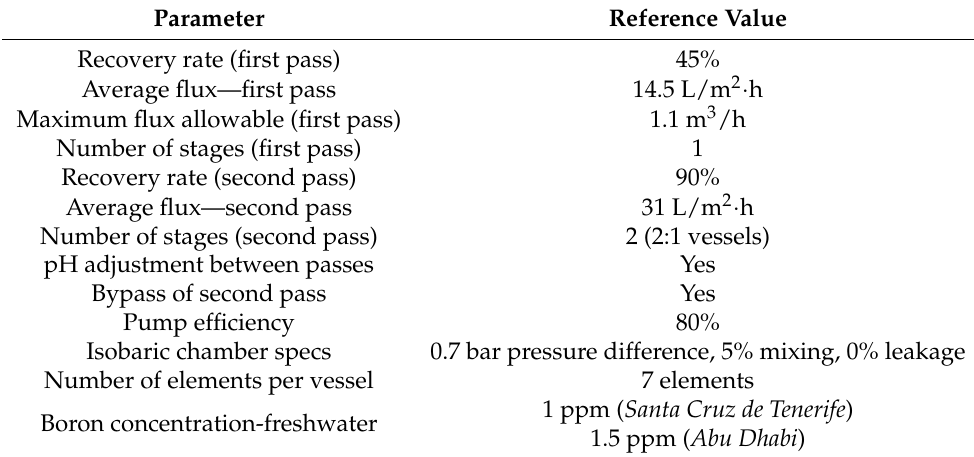
Table 3. Design criteria of the seawater reverse osmosis plant modelled with